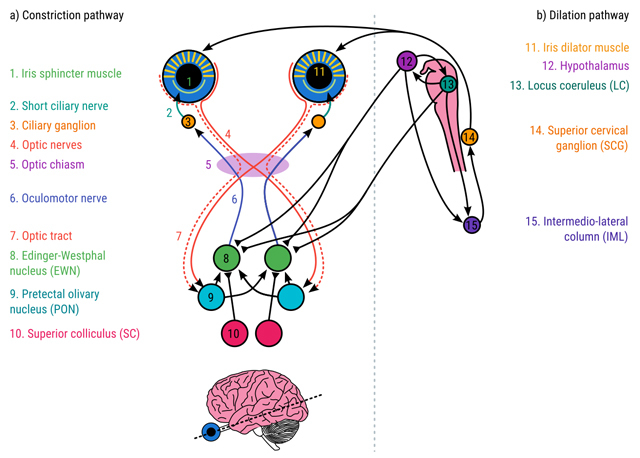
a) The pupil constriction pathway. b) the pupil dilation pathway. (Based on Kardon, 2005; McDougal & Gamlin, 2008; Samuels & Szabadi, 2008; Szabadi, 2012; C. Wang & Munoz, 2015).